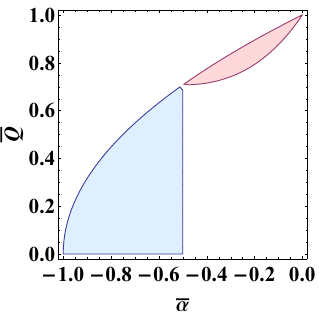
Figure 7 . The unstable regions of the asymptotically (cid:13)at charged Gauss-Bonnet black hole are shown in ( (cid:11); Q ) plane. The light red region corresponds to f 2 < 0 and the light blue region corresponds to f 1 < 0, since these two regions have no overlap, both of them belong to the unstable regions.